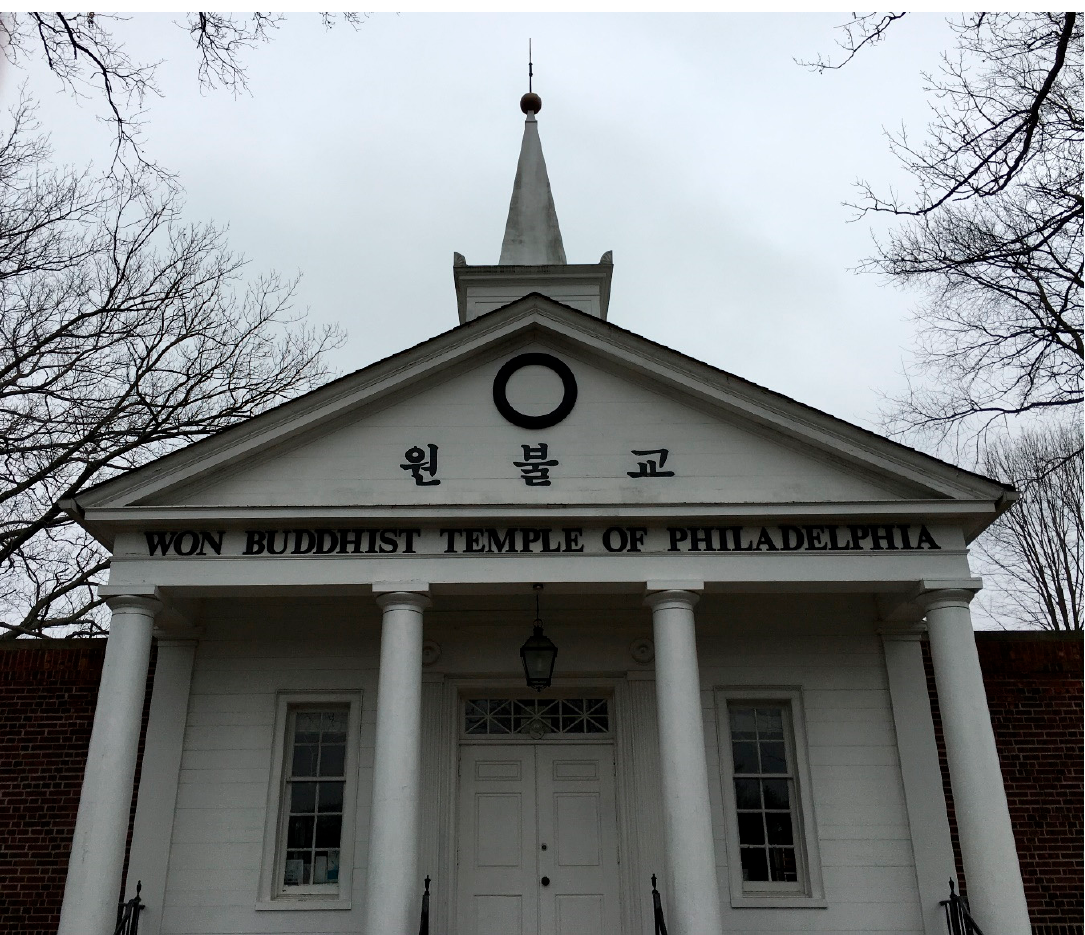
Figure 6. Won Buddhist temple (Glenside, PA). Source: www.jivaka.net.